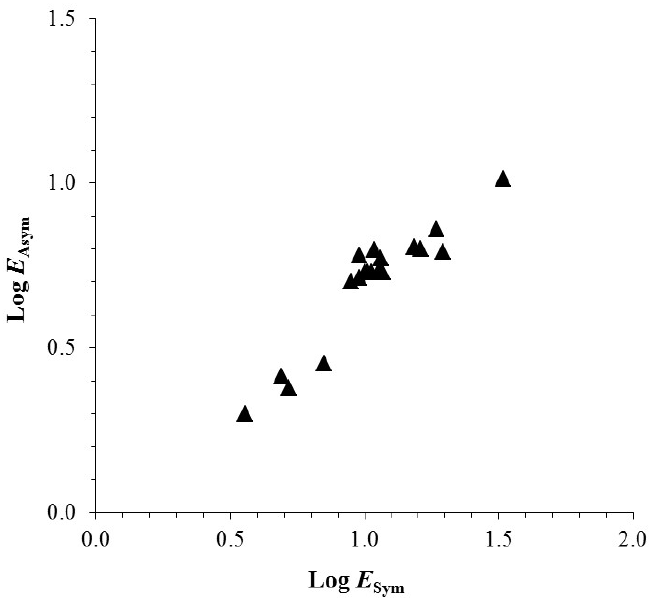
Figure 1. Relationship between the enhancement factors under the asymmetric conditions ( E ) and those under the symmetric conditions ( E Asym Chantasart and Li